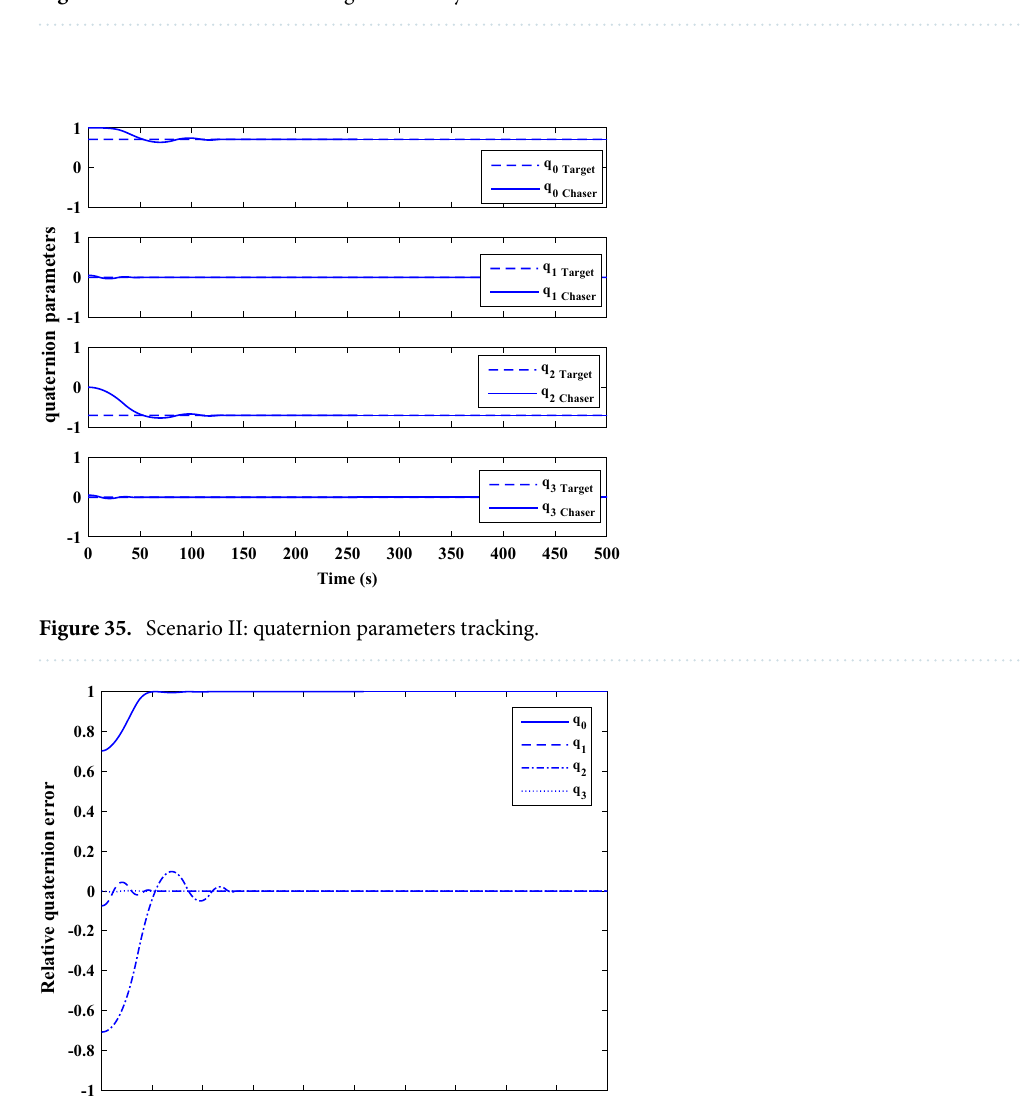
Figure 34. Scenario II: relative angular velocity error.